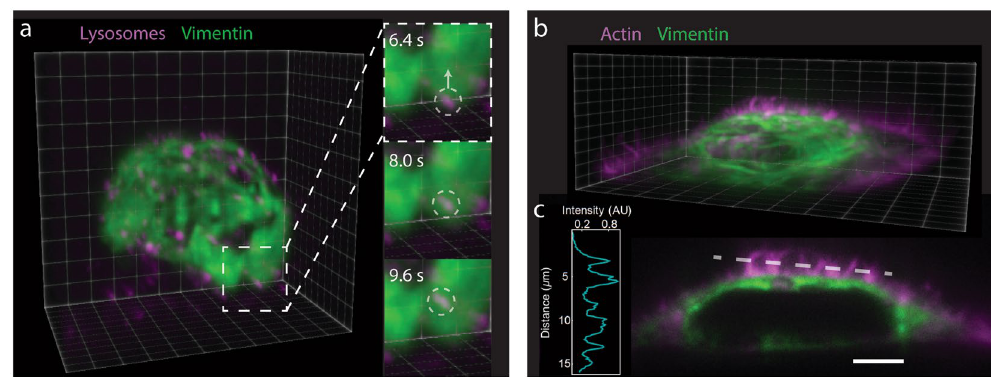
Figure 2. Volumetric imaging of vimentin cytoskeleton and lysosome movement. ( a ) LSFM volumetric imaging of a live HeLa cell with labeled Lysotracker Red (magenta) and vimentin-mEmerald (green). Each volume consists of 75 slices per color acquired at 5 ms exposure time and 5 ms readout time; the total volume acquisition time is 1.5 s. A 100 ms delay is taken between volumes. Insets show dynamics of vesicles on the single-second timescale. Voxel size: 106 × 106 × 220 nm. Total volume: 29.3 × 26.3 × 16.5 µ m (See Supplementary Video 1). ( b ) LSFM volumetric image of a fixed HeLa cell with labeled actin (AlexaFluor 568-Phalloidin - magenta) and vimentin-mEmerald (green). The volume consists of 300 slices per color acquired at 5 ms exposure time and 5 ms readout time; the total volume acquisition time is 6 s. Voxel size: 106 × 106 × 108 nm. Total volume: 52.6 × 19.1 × 32.4 µ m (See Supplementary Video 2). ( c ) Selected side-view image from the volume data set shown in ( b ). A single-pixel line scan (dashed white line) through the actin channel shows we resolve individual filopodia at the above volume acquisition rate with adequate signal-to-noise (inset). Scale bar = 5 µ